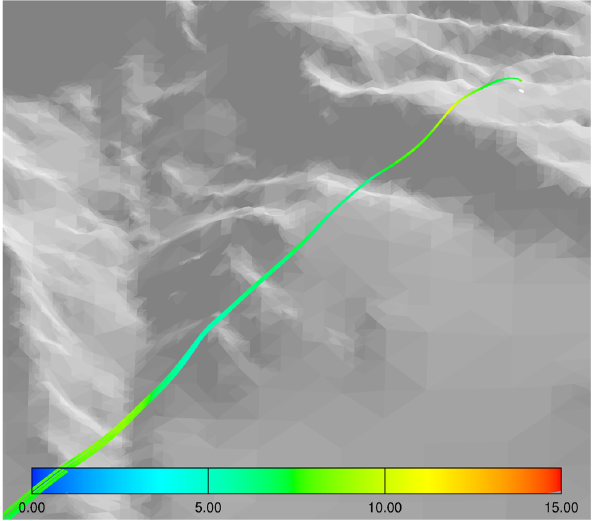
Figure 3 : Modified wind field streamlines from the top of